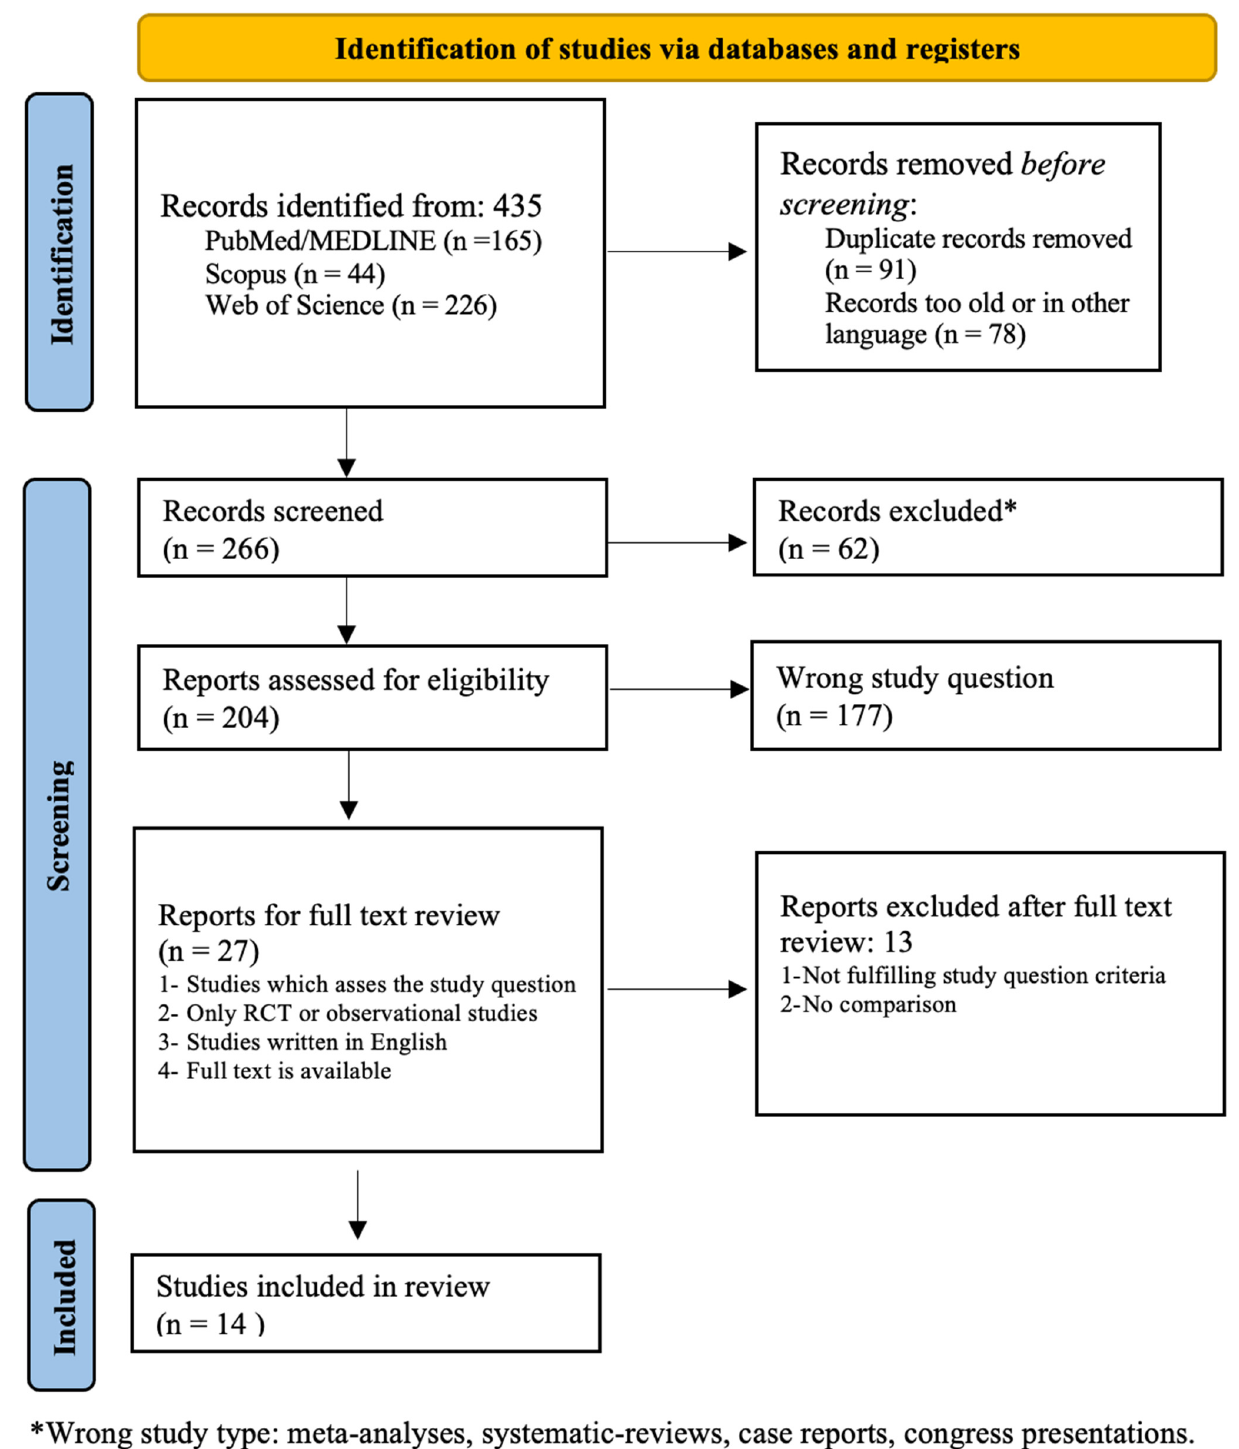
Figure 1. PRISMA 2020 flow diagram. From: Page MJ, McKenzie JE, Bossuyt PM, Boutron I, Hoffmann TC, Mulrow CD, et al. The PRISMA 2020 statement: an updated guideline for reporting systematic reviews. BMJ 2021;372:n71. doi: 10.1136/bmj.n71. For more information, visit: